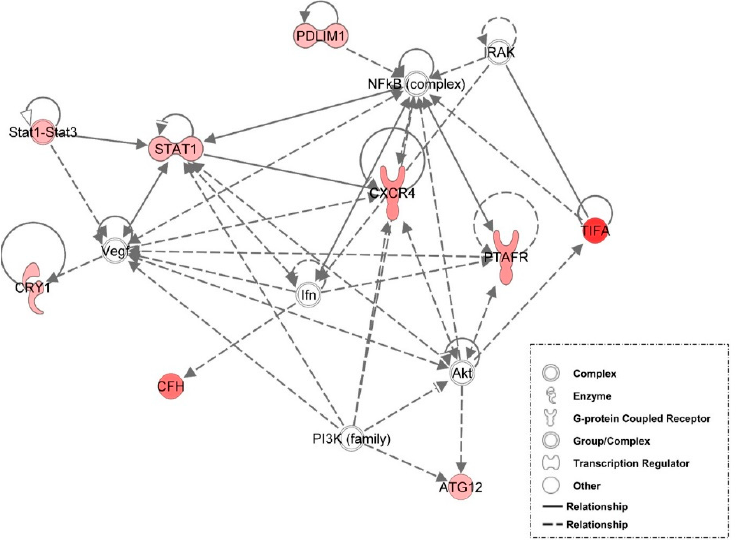
Figure 7. Network mapping of miR-146b target genes. There was a decrease in miR-146b adipocytic expression, from E18 to D3. Several miR-146b target genes involved in cellular movement and immune cell trafficking were upregulated during this time. Red molecules had significantly ( p < 0.05) higher expression in D3 adipose tissue. Solid lines indicate a direct interaction and dashed lines indicate an indirect interaction.